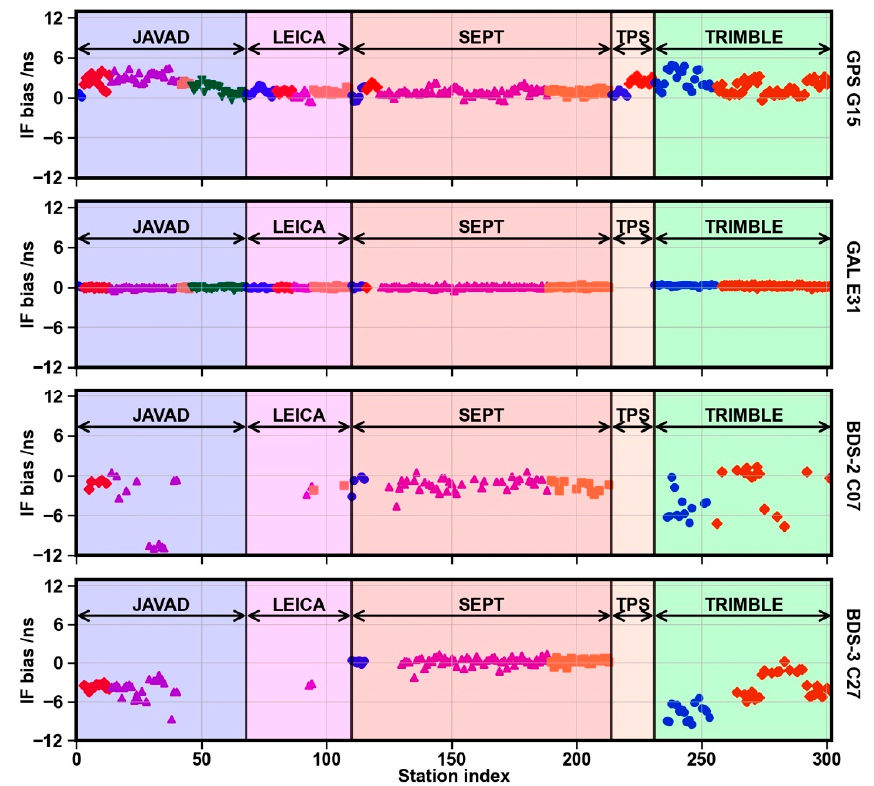
Figure 3. Average receiver ‐ related IF SDBs from DOY 45 to 51,